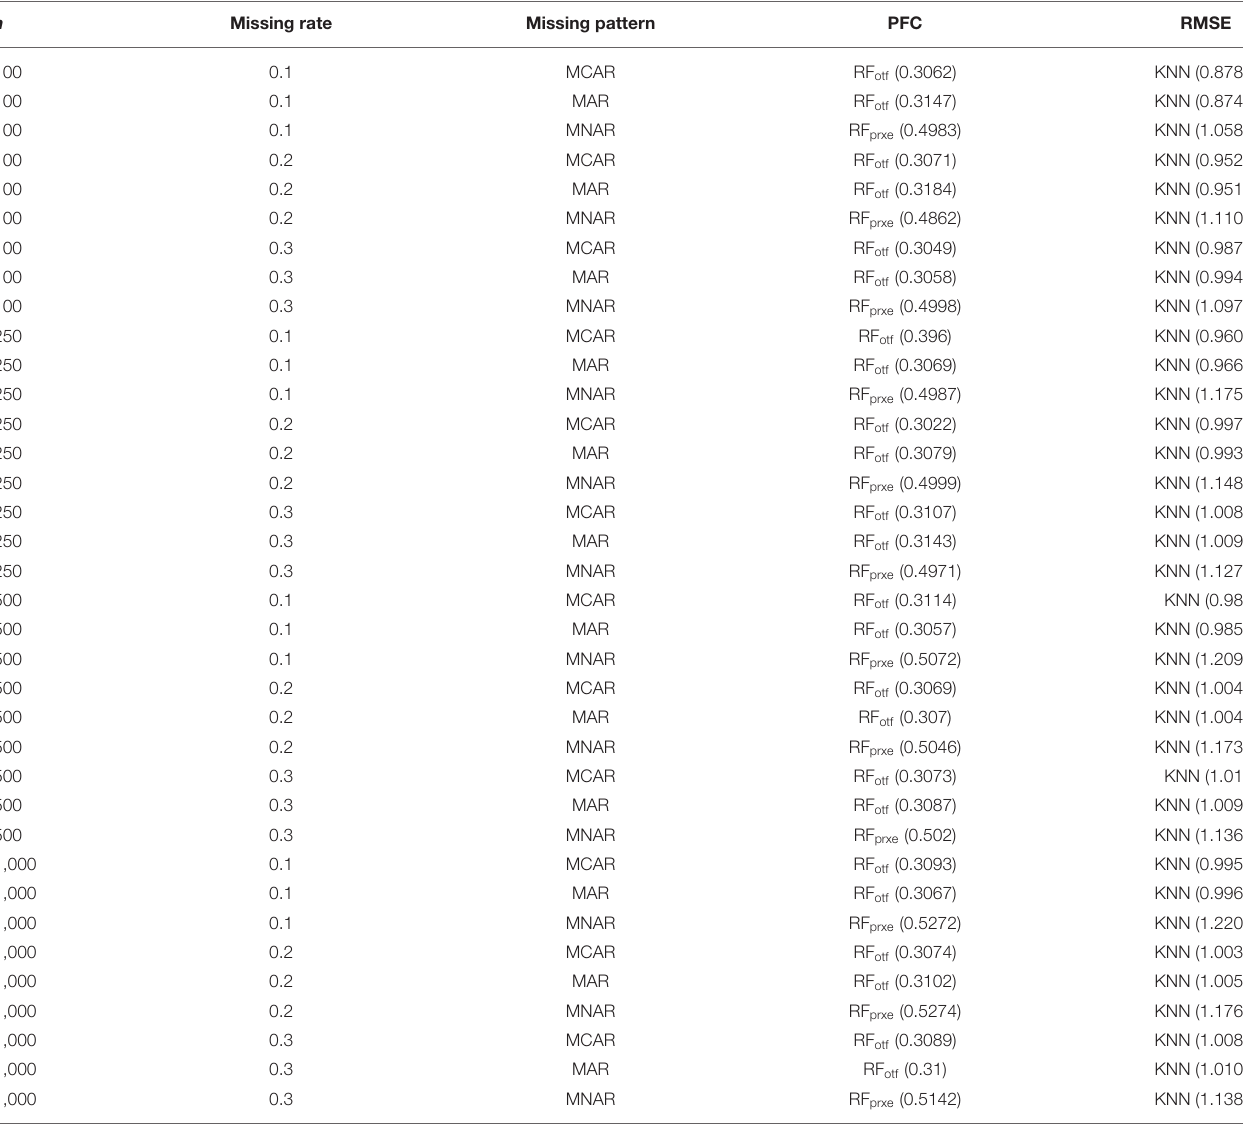
TABLE 1 | The best performer for proportion of falsely classified (PFC) and root means square error (RMSE). n Missing rate Missing